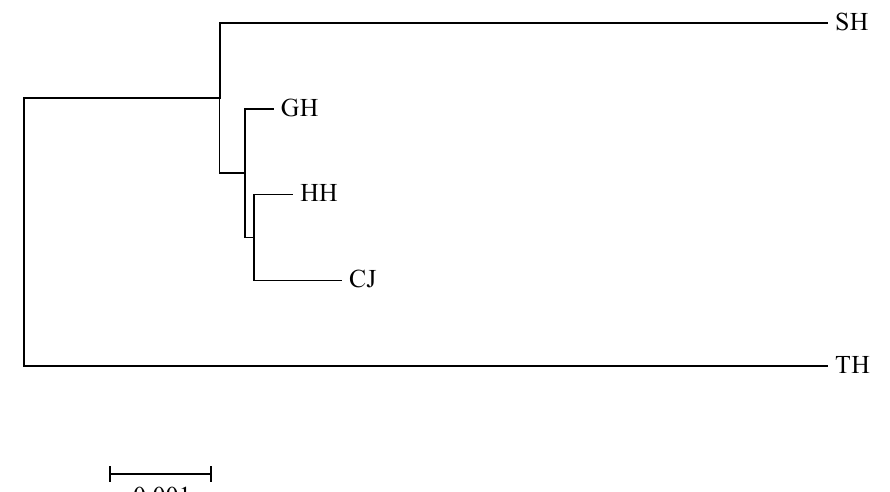
Figure 4. NJ trees of 5 populations based on genetic distance.